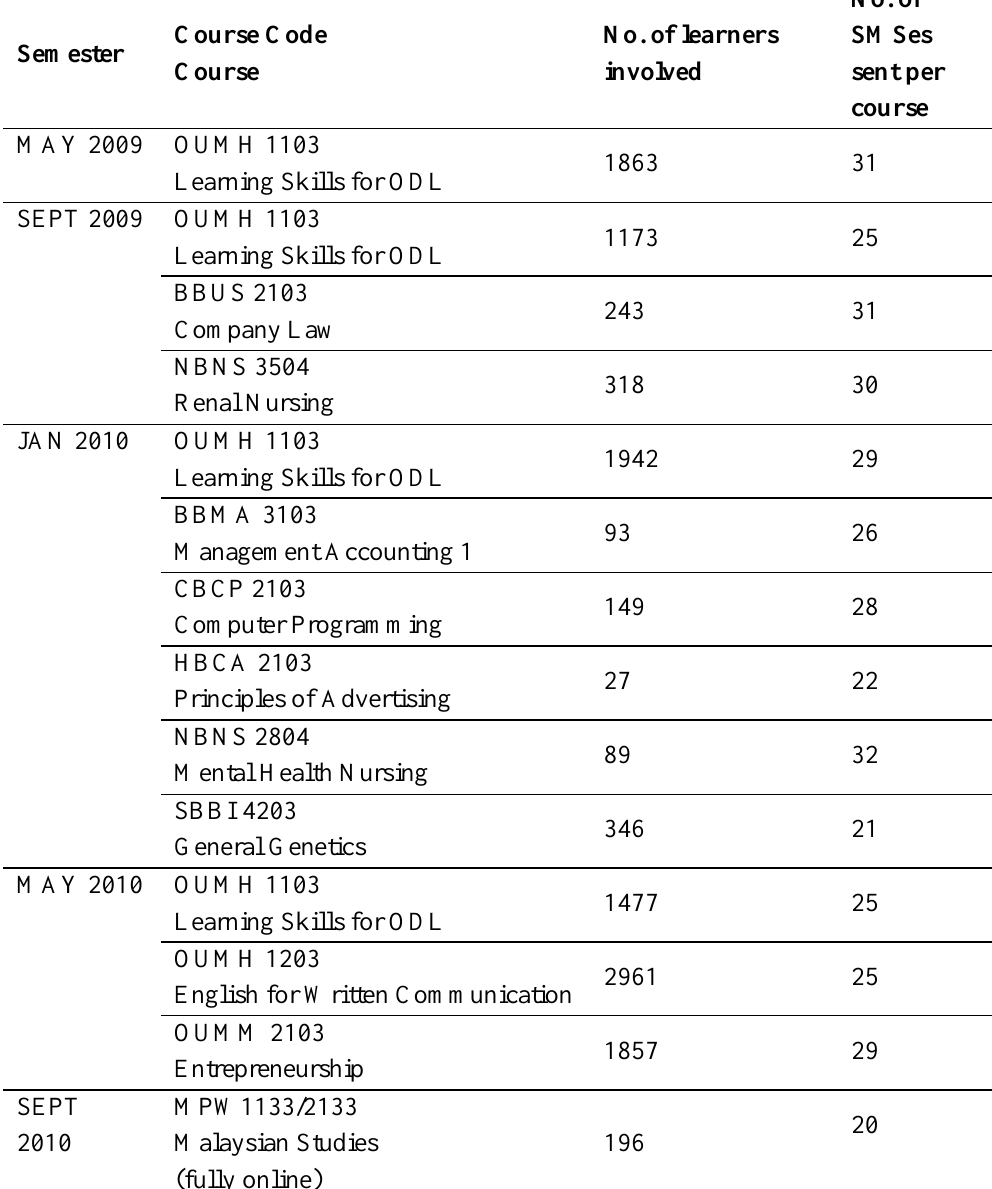
Table 3 Details of Mobile Learning